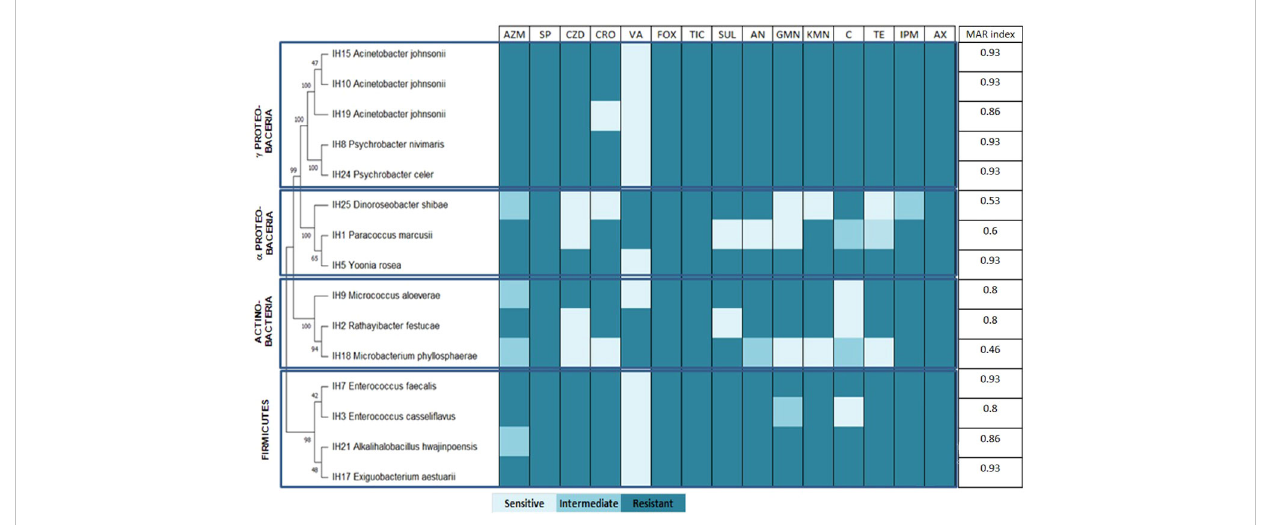
FIGURE 3 Antibiotic resistance pro fi le of Ulva ohnoi -associated bacteria. AZM, azithromycin; SP, spiramycin; CZD, ceftazidime; CRO, ceftriaxone; VA, vancomycin; FOX, cefoxitin; TIC, ticarcillin; SUL, sulfonamides; AN, amikacin; GMN, gentamicin; KMN, kanamycin; C, chloramphenicol; TE, tetracycline; IPM, imipenem; AX,